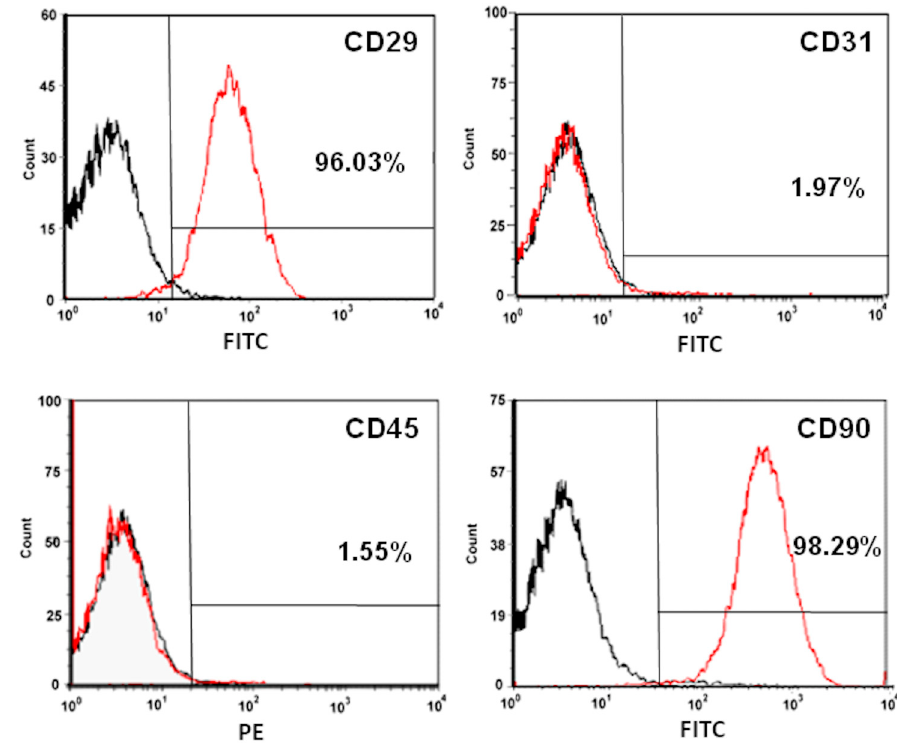
Figure 9. ASC surface marker expression detected by flow cytometric analysis. Surface marker analysis of cells from cultured rat adipose tissues using flow cytometry. ASCs were defined as CD29 + /CD31 − /CD45 − /CD90 + . The percentages are the mean values from three experiments. The red line represents positive staining cells and the black line stands for iso-type-matched antibody control.